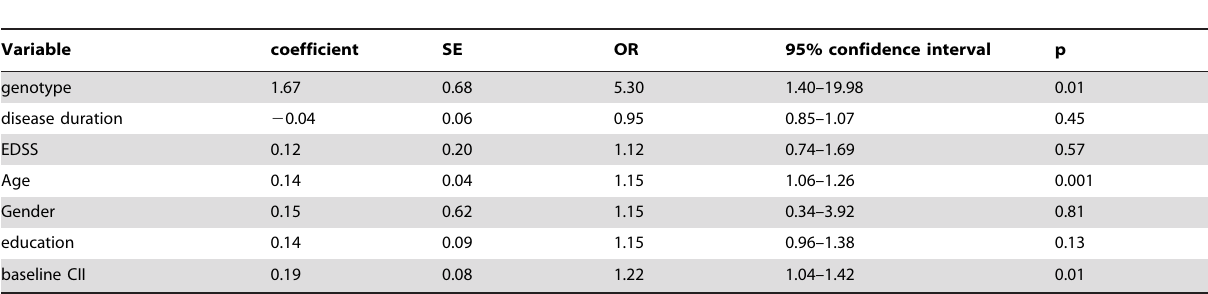
Table 5. Logistic regression (CII worsening as response